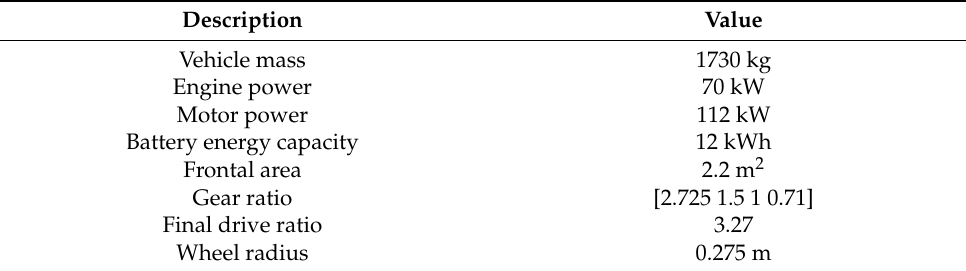
Table 1. Vehicle